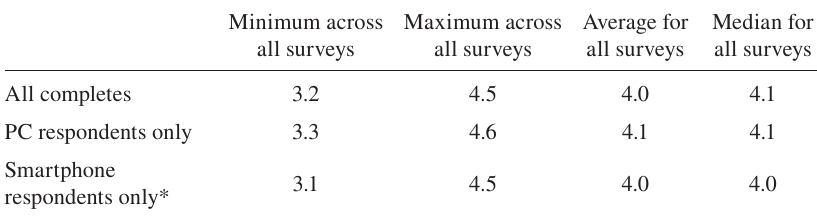
Evaluation of the survey: average on a scale from (1) very badly done to (5) very well done Minimum across Maximum across all surveys all